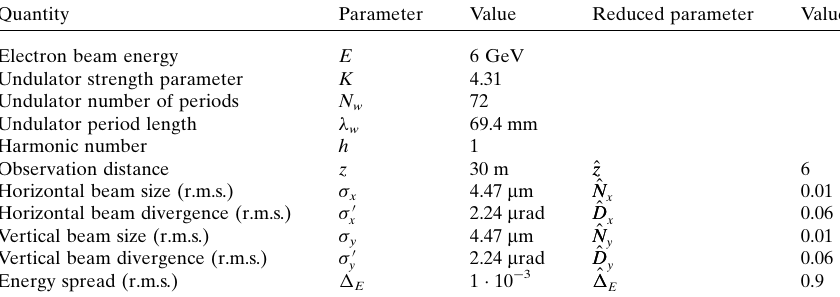
Table 3 Main parameters of the fourth-generation undulator source near the diffraction limit; reduced quantities based on equations (2) and (11) are also